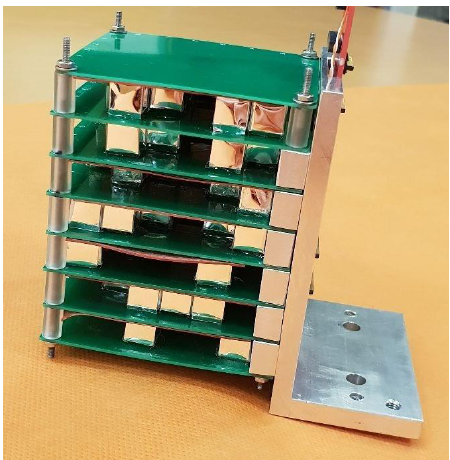
Figure 4. Laboratory model of the GALI detector system with 90 scintillators crystals. The individual scintillators in their reflective wrappings can be seen, arranged in a random order. A larger version is currently being built for the